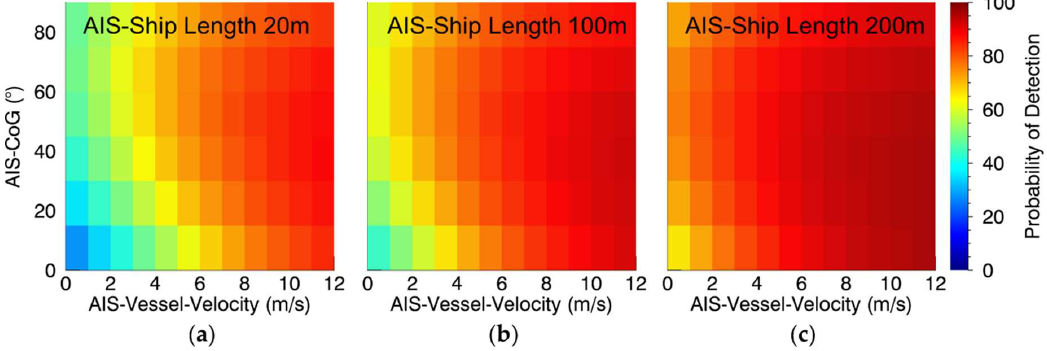
Figure 5. 2D detectability charts based on AIS-Vessel-Velocity, AIS-CoG and from left to right AIS-Length with: ( a ) 20 m, ( b ) 100 m, and ( c ) 200 m.